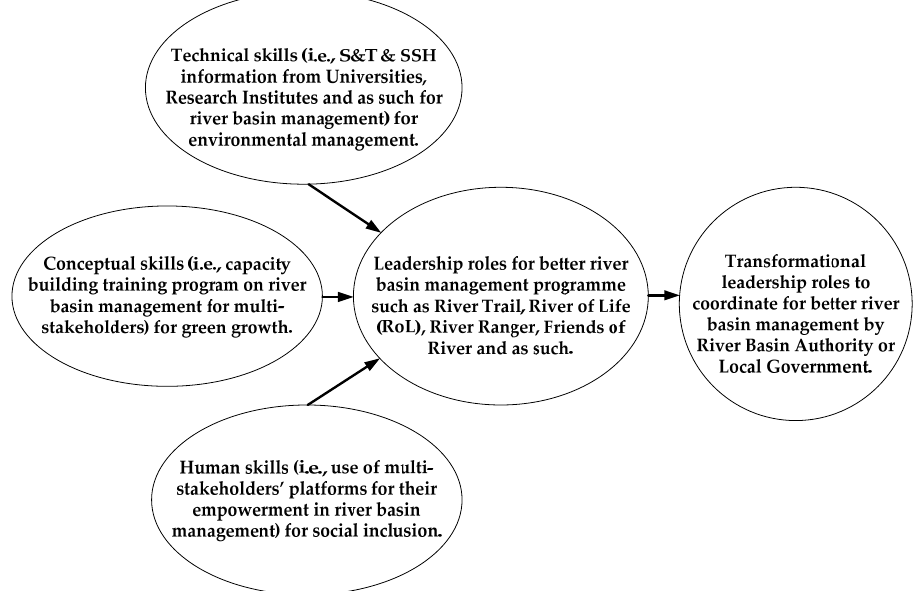
Figure 6. Conceptual framework of better Langat River Basin Management Authority (LRBMA) following modified transformational [66] and behavioral leadership [67,68] theories. Note: S and T = science and technology; SSH = social science and humanities. Table 9. Local authorities and its administrative areas at Langat River Basin, Malaysia [77].